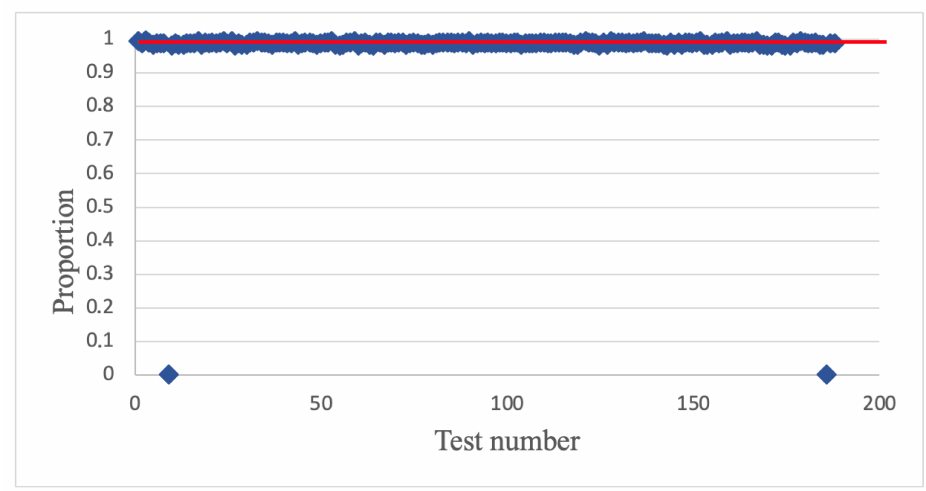
Figure 5. Statistical portrait of the LFSR ( F ( x ) = 1 + 18 x + 31 x , matrix T 1, power of the matrix r = 10).